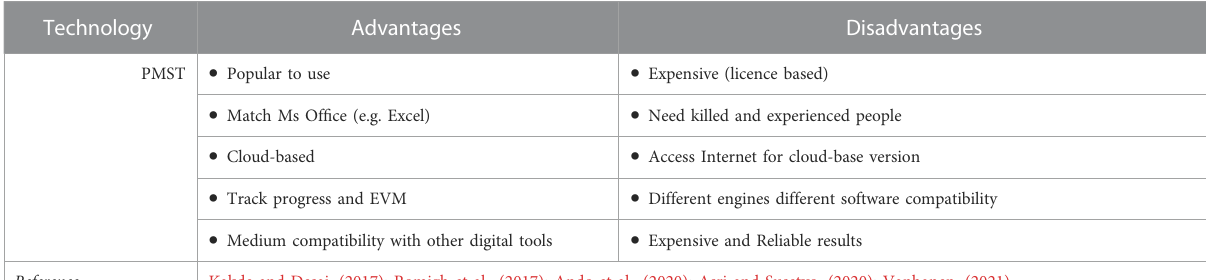
TABLE 8 ( Continued ) Key advantages and disadvantages: single digital technologies.